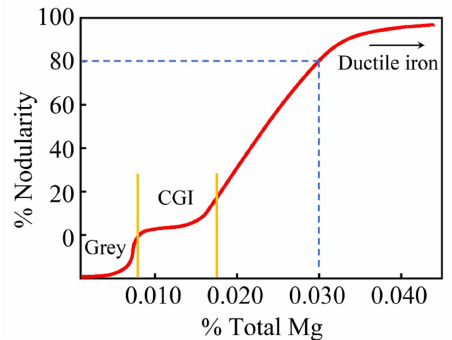
Figure 3. Relationship between total residual magnesium content and nodularity.